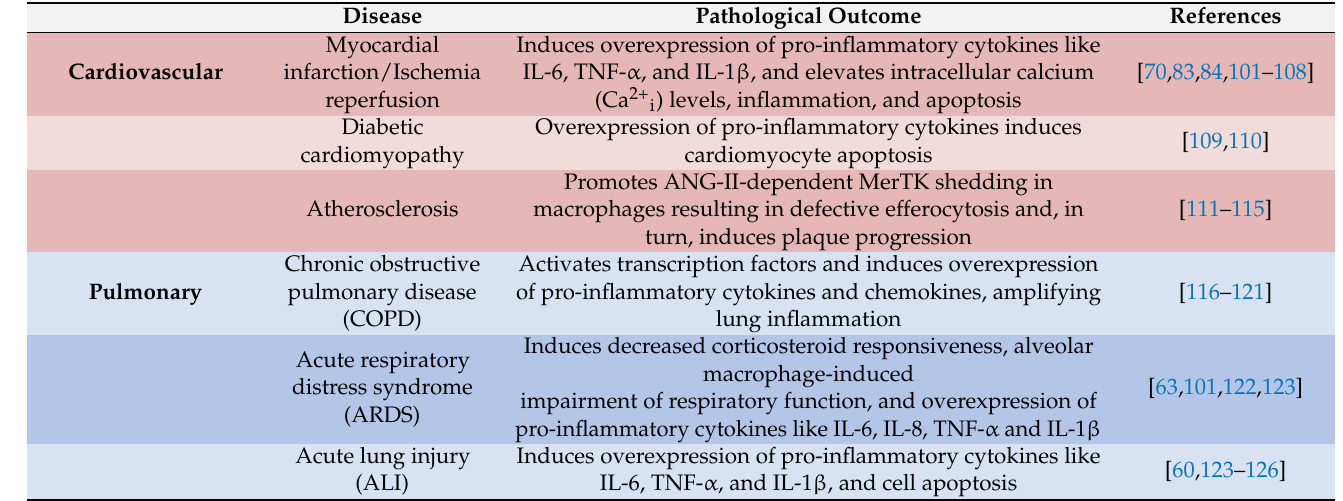
Table 2. Pathological role of p38 MAPK signal transduction in a variety of diseases. Disease Pathological